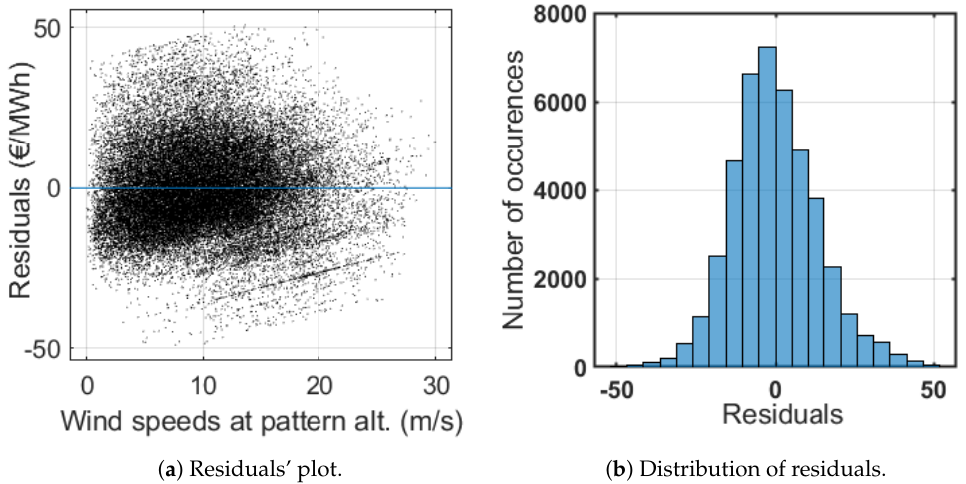
Figure 9. Residuals’ analysis plots.